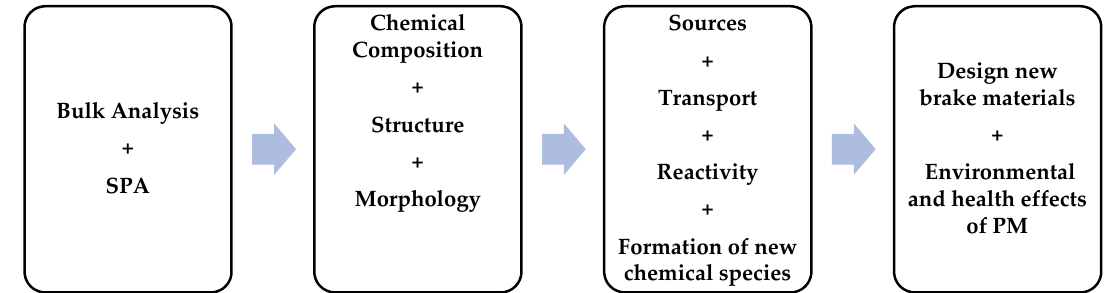
Figure 2. Characterization flow diagram (SPA = single particle analysis).